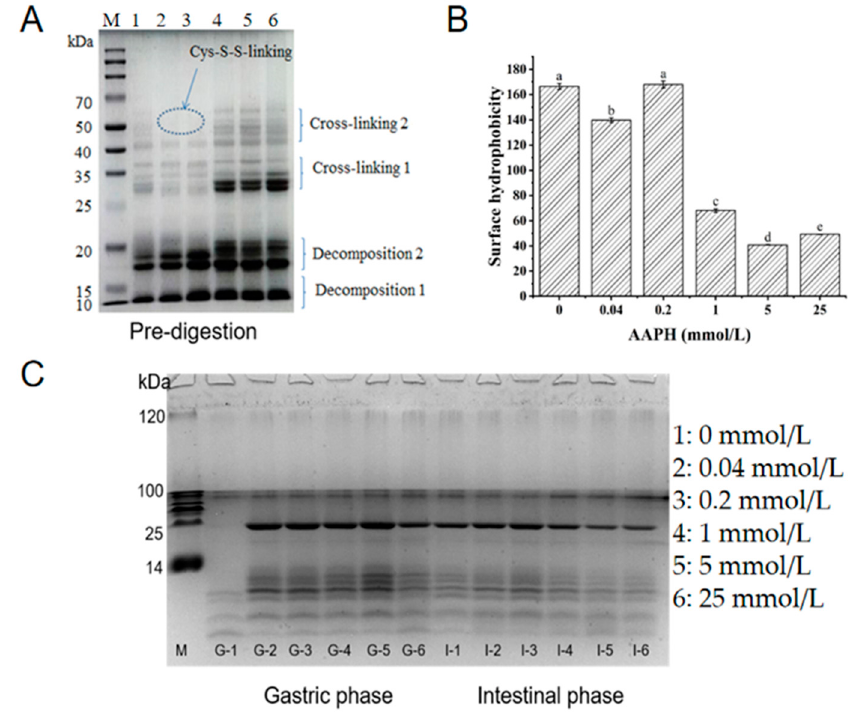
Figure 2. ( A ) Electrophoresis profiles of walnut isolated proteins after 24 h of incubation with different concentrations of AAPH, the circle shows the cross-linking of two sulfhydryl groups of cysteine due to oxidation; ( B ) surface hydrophobicity; and ( C ) small-molecule electrophoresis profiles of walnut isolated proteins after AAPH oxidation in gastric and subsequent intestinal digestion for 2 h, respectively, G: gastric phase, I: intestinal phase, and different letters (a–e) indicate significant differences at p < 0.05.